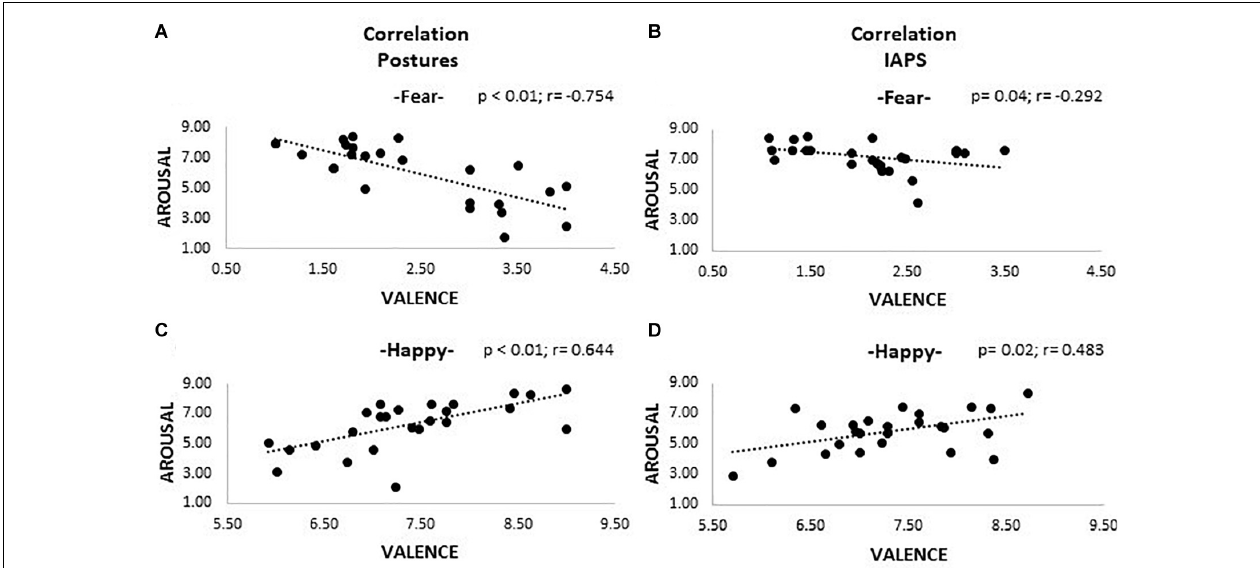
FIGURE 3 | Correlation plots. The picture shows four plots where correlations between valence and arousal are observable. Plots (A) and (C) show the results for the posture trials; (B) and (D) the ones for the IAPS trials. A positive correlation is appreciable for positive emotional pictures (happiness; plots C and D ), meaning that higher valence corresponds to higher activation; the opposite is observable for negative pictures (fear; plots A and B ), even though for IAPS, stimuli significance was not reached after Bonferroni correction. Both valence and arousal are reported as values on the 0–9 Likert scale. Legend: $ = p > 0.05. TABLE 3 | Cronbach’s alpha for valence and arousal. Postures